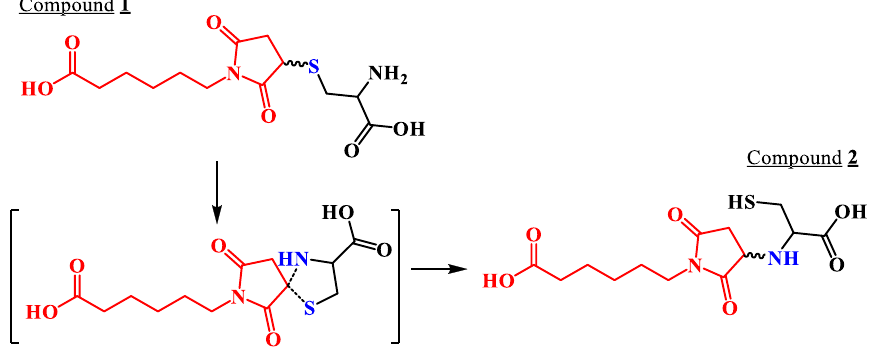
Figure 5. Possible formation of the cyclic intermediate between Compounds 1 and 2 .